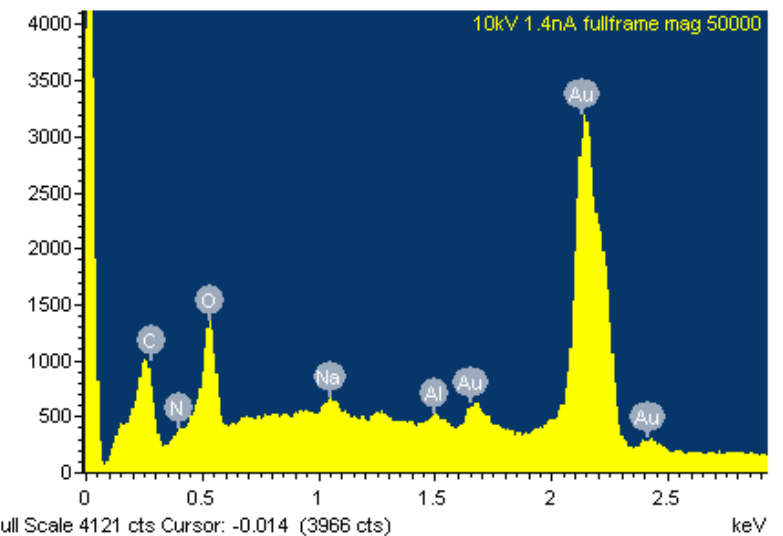
Fig. 2. Characteristics emission of the elements abundant in the urine NPs under excitation by electron beam 10 kV, 1.4nA. The x -axis represents the energies of emitted photons from 0.1 to 2.8 keV with the speci¯ed peaks at 0.24 (carbon C), 0.4 (nitrogen N), 0.52 (oxygen O), 1.05 (sodium Na), 1.5 (aluminum Al) and three peaks at 1.65, 2.15 and 2.4 keV of the gold Au. The y -axis represents the intensity of emission in linear arbitrary unites. Note that the line amplitudes do not determine directly the elements concentrations measured in the weight %.